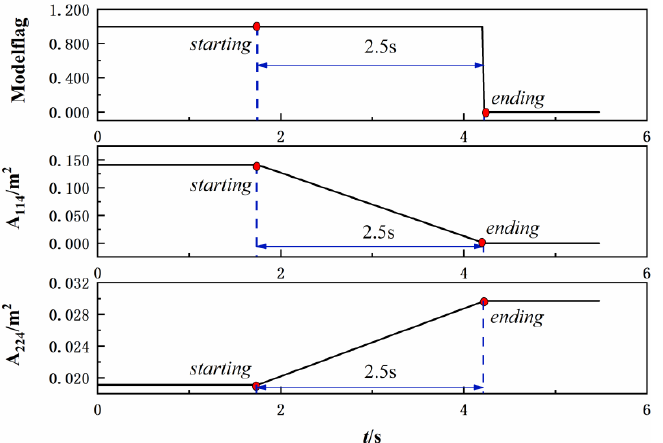
Figure 8. Schedule of control variables with fixed values switching from double bypass to single bypass mode.